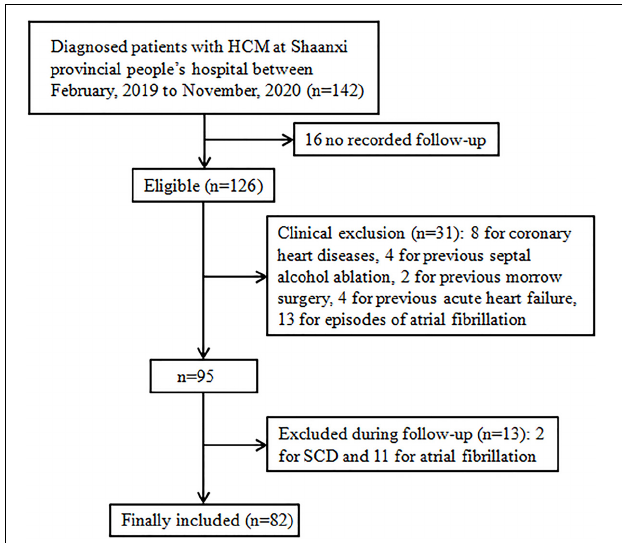
FIGURE 2 | Flow chart. Study selection process: over 142 patients were diagnosed with HCM at Shaanxi Provincial People’s Hospital between February, 2019 and November, 2020 ( n = 142), 16 did not have available follow-up data, 8 for coronary heart diseases, 4 for previous septal alcohol ablation, 2 for previous morrow surgery, 4 for previous acute heart failure, 2 for SCD, 10 for previous episode of atrial fibrillation, 11 for onset of atrial fibrillation during follow-up, and 2 for onset of SCD during follow-up; HCM, hypertrophic cardiomyopathy, SCD, sudden cardiac